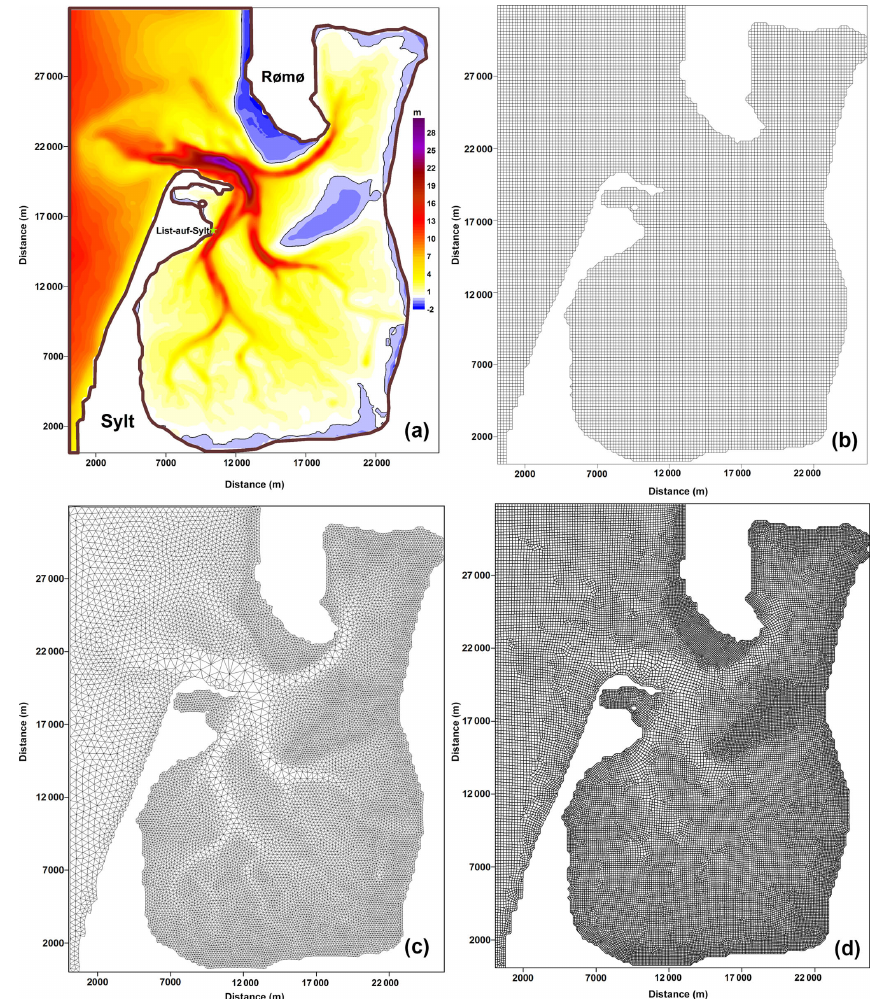
Figure 2. (a) The bathymetry of the Sylt–Rømø Bight (provided by Hans Burchard, personal communication, 2015) with the location of station List-auf-Sylt; (b) the regular quasi-quadrilateral MESH-1 (200m; 16089 vertices, 15578 quads, and 176 triangles); (c) the triangular MESH-2 (14193 vertices and 27548 triangles); and (d) the irregular quadrilateral MESH-3 (35639 vertices, 34820 quads, and 31